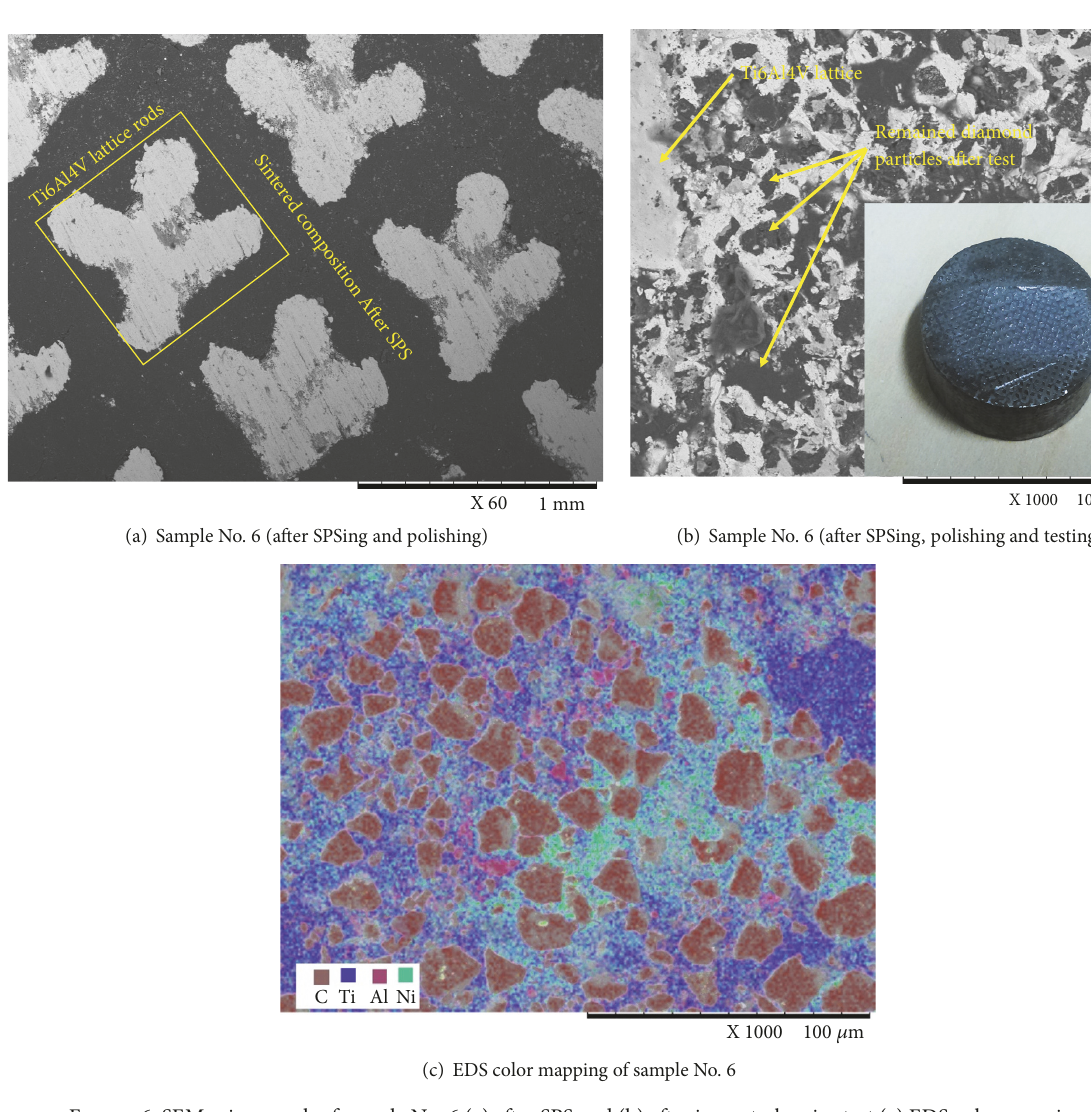
content in top layer provides extreme hardness and higher wear